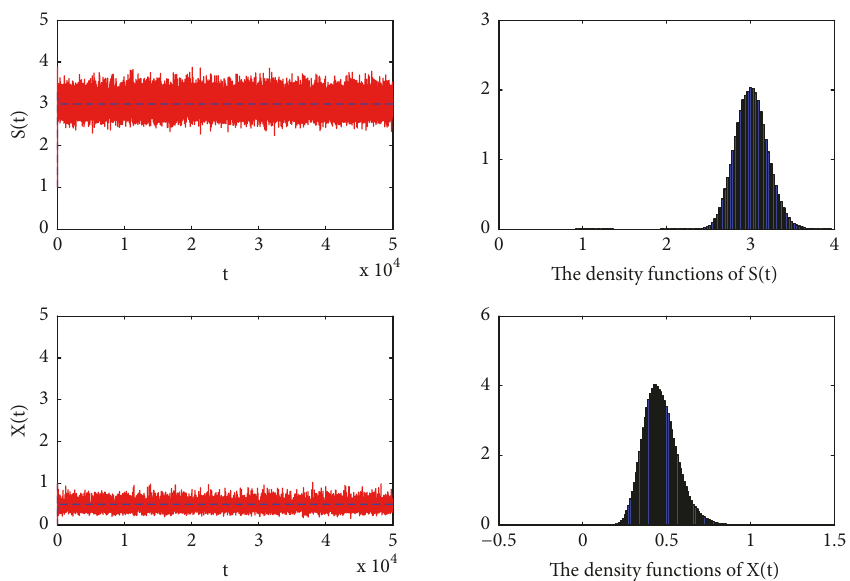
Figure 3: There also exists a stationary distribution of (𝑆(𝑡),𝑋(𝑡)) , and the fluctuation is reduced with the decreasing of the white noise. The lines have the same meaning as Figure 2.